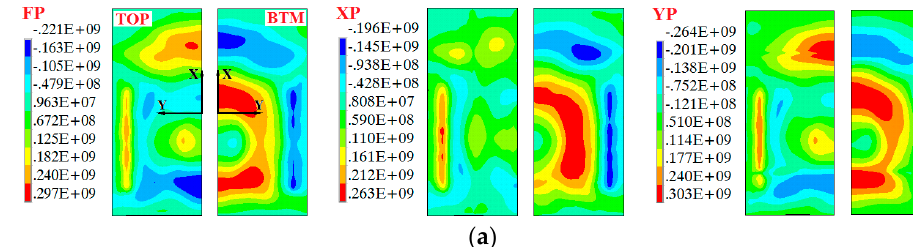
Figure 13. Equivalent plastic strain distribution of four panels in the early stage of each discharge: ( a ) FP; ( b ) XP; ( c ) YP; and ( d )